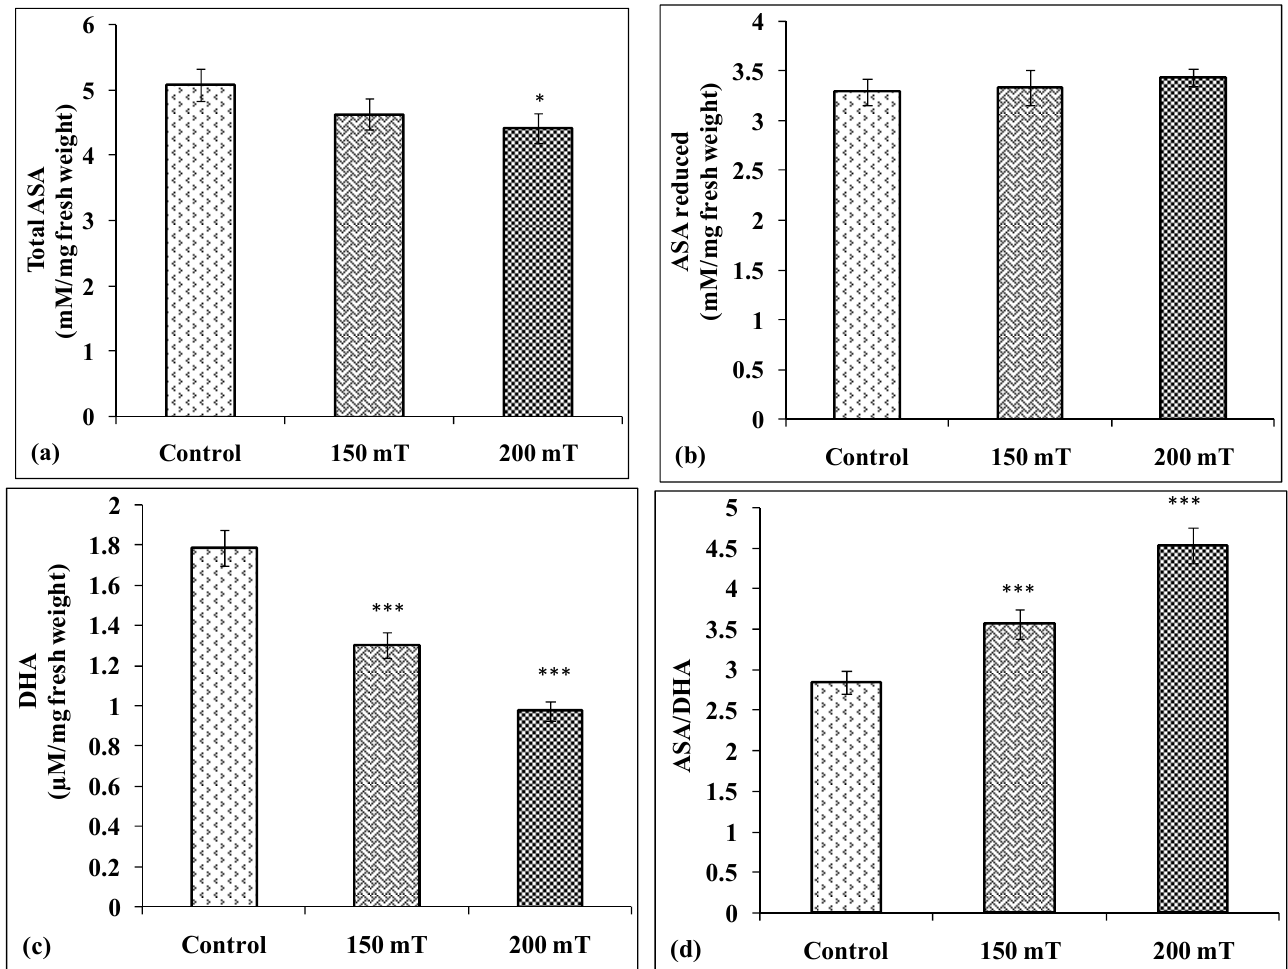
Figure 11. Effect of pre-sowing magnetic field treatment of soybean seeds on ascorbic acid content: Total ASA ( a ), reduced ASA ( b ), DHA ( c ), and ASA/DHA ( d ). *** and * indicate significance at p < 0.001 and 0.05, respectively, compared to control.